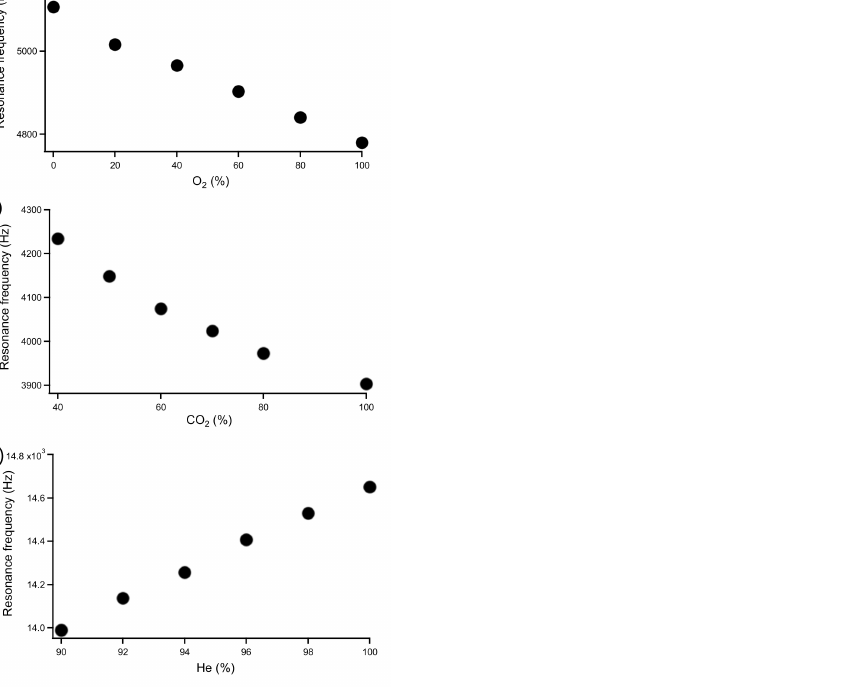
Figure 5. The relationship between resonance frequency and gas composition. ( A ) O 2 , ( B ) CO 2 , and ( C ) He in N 2